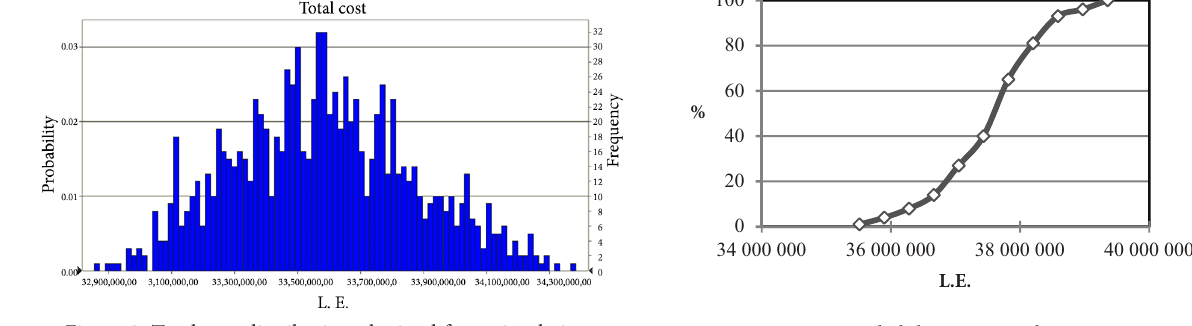
Figure 3. Total cost distribution obtained from simulation Figure 4. Probabilistic Material Cost Curve